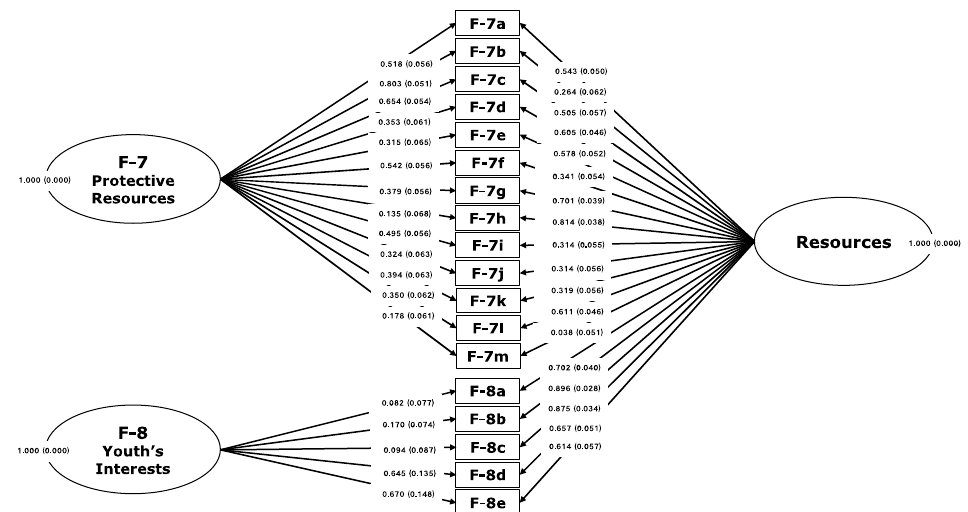
Figure 3. Mapping of confirmatory bifactor analysis of six facets of risks on the FER ‐ R.